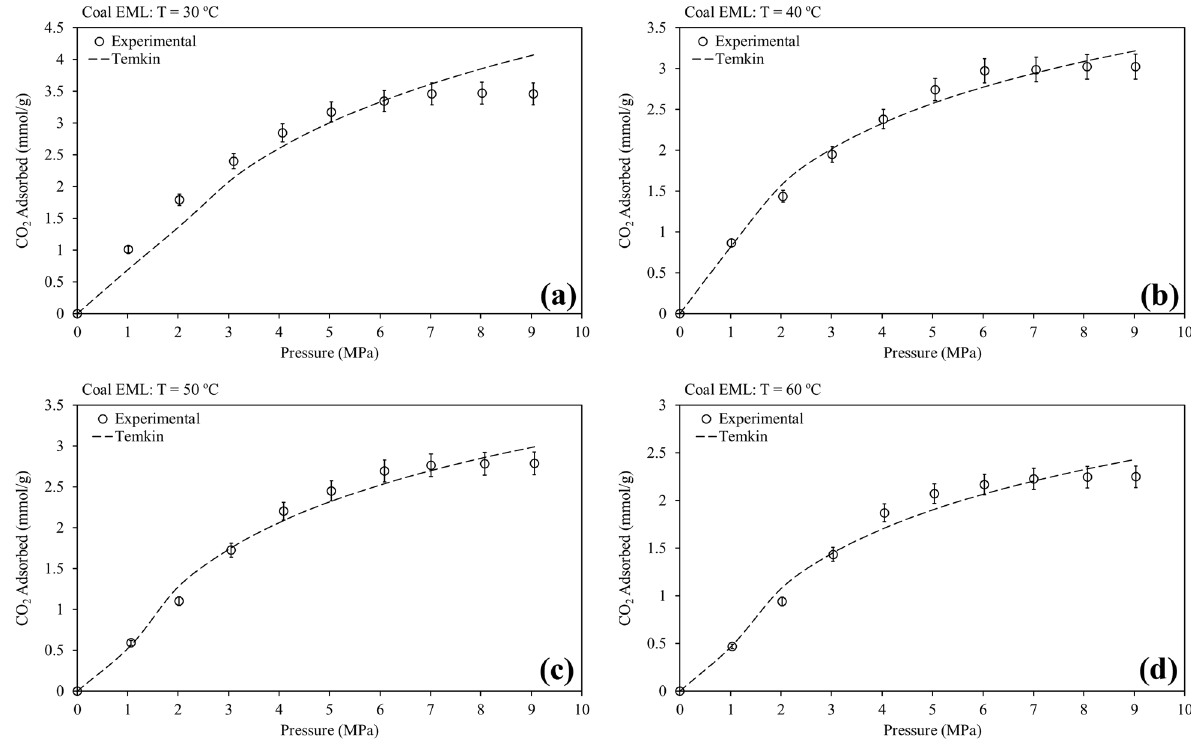
Fig. 5 Temkin isotherm model fit for pure CO 2 sorption on Coal EML at a 30 ºC, b 40 ºC, c 50 ºC, and d 60 ºC